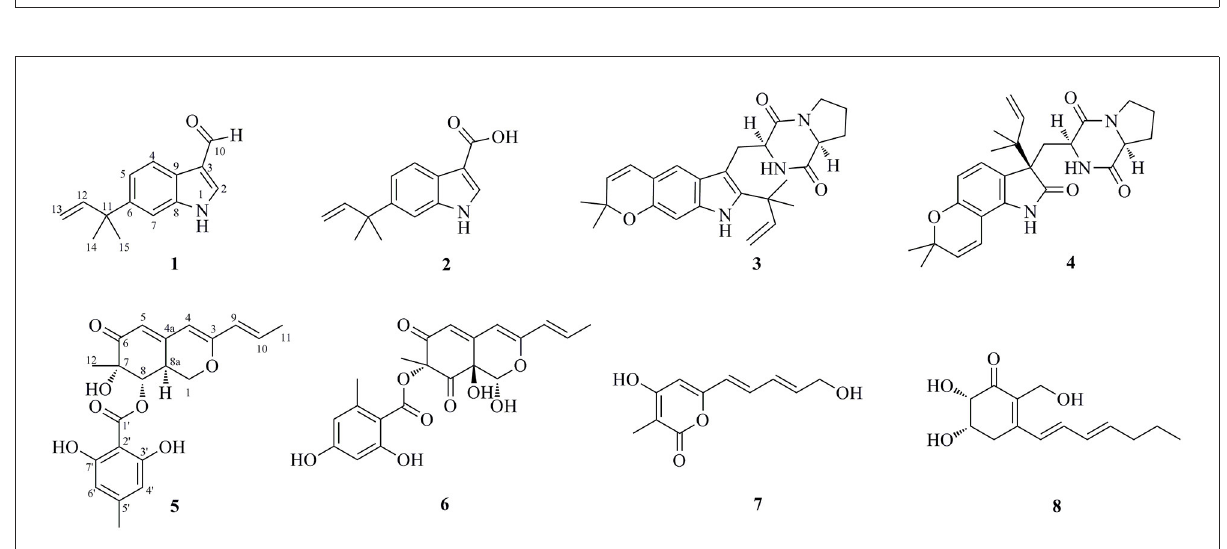
FIGURE2 Chemical structures of the isolated compounds 1 – 8